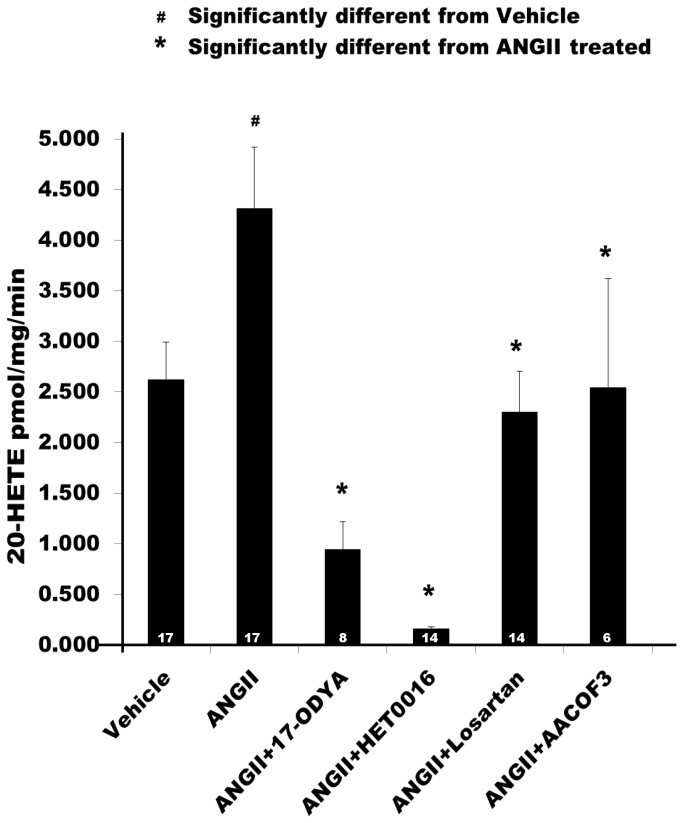
Effect of ANG II on the production of 20-HETE in renal microvessels.Comparison of the production of 20-HETE in renal microvessels treated with vehicle, ANG II and ANG II plus inhibitors of the synthesis of 20-HETE, 17-ODYA (10-5 M) and HET0016 (10-6 M), a phospholipase A2 inhibitor, AACOF3 (2 X 10-5 M), a phospholipase C inhibitor, of U-73122 (10-5 M), and the AT1 receptor blocker, Losartan (10-6 M). Numbers in the bars indicate the number of vessel preparations studied. # indicates a significant difference from the corresponding value in vessels treated with vehicle. * indicates a significant difference from the corresponding value in vessels treated with ANG II (10-7 M).